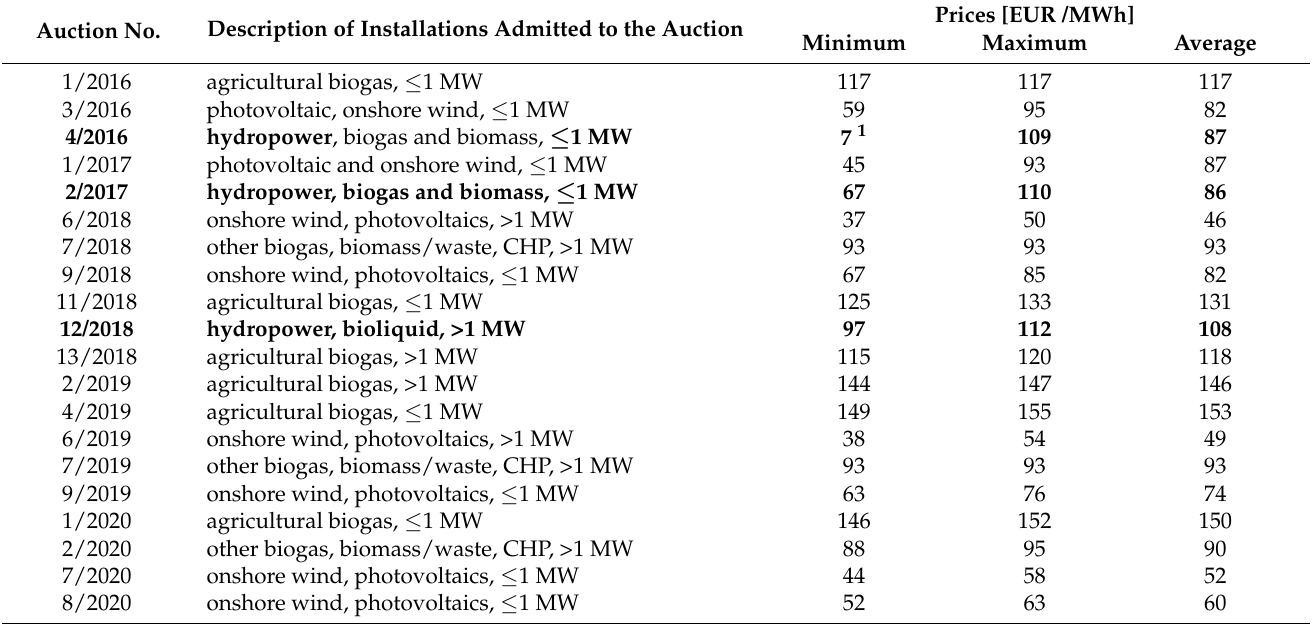
Table 9. Auction prices of the electric energy from the RES in